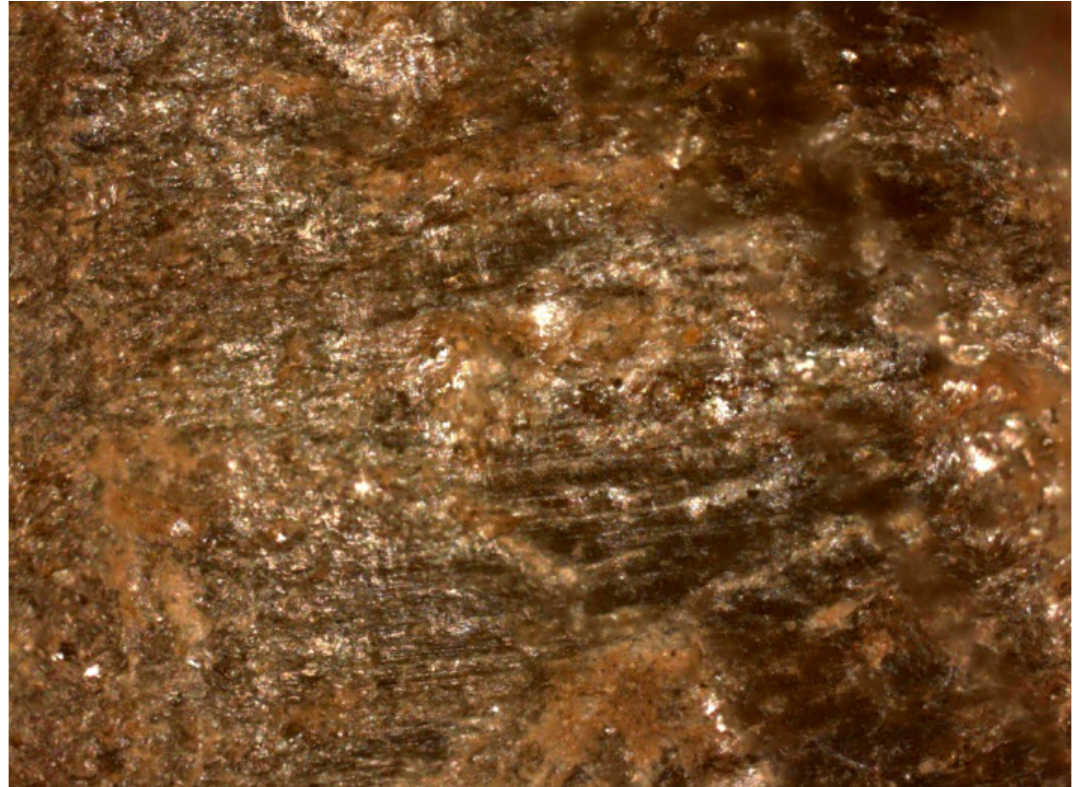
Figure 8. The use-wear traces (50x) in the groove left by straightening of the wooden (willow) shafts. TGA talc replica. (Photo by S.N.